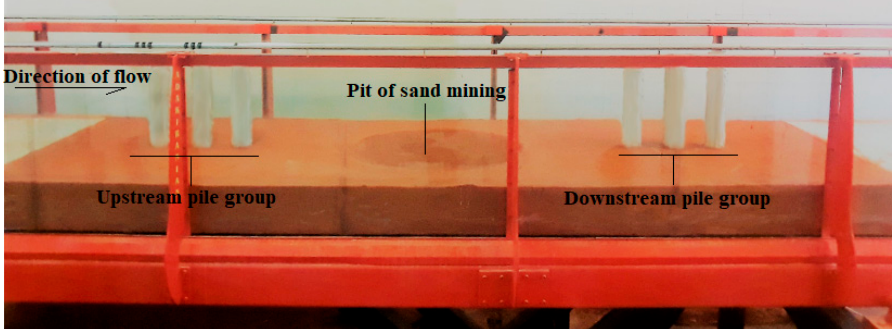
Figure 1. Sediment bed, material harvesting pit, and arrangement of the bridge pile groups in the laboratory model.